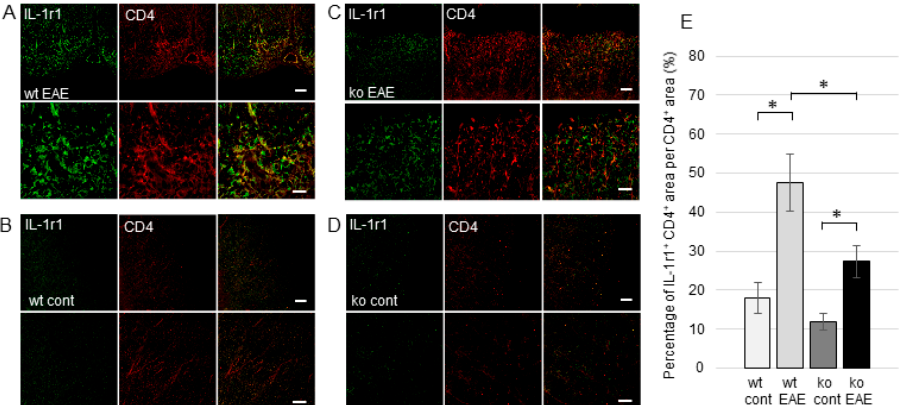
Figure 6. Expression of interleukin-1 receptor 1 (IL-1r1) in CD4 + T cells in the spinal cords of EAE and control mice. Immunohistochemistry image showing IL-1r1 (green) and CD4 (red) in the inflammatory region of the spinal cords of wt EAE ( A ), wt control ( B ), ko EAE ( C ), and ko control ( D ) mice. Percentage of the IL-1r1 + CD4 + area in the CD4 + area of EAE spinal cords ( E ). Scale bar (50 μ m) for upper panels and (20 μ m) for lower panels of ( A – D ). wt, wild-type; ko, mPGES-1 − / − ; cont, naïve mice; EAE, EAE mice. * p < 0.05.